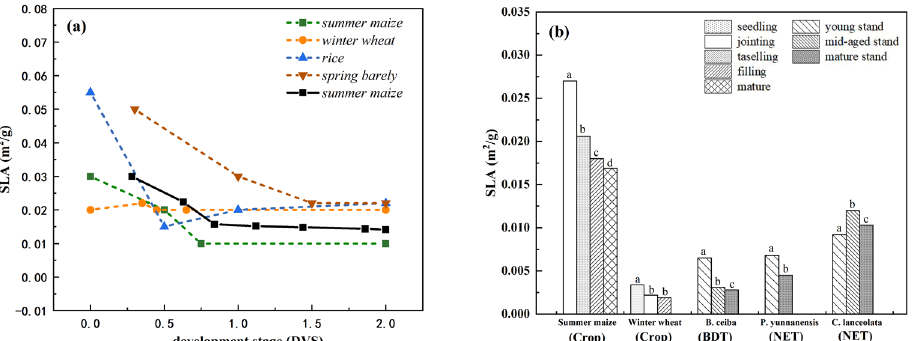
Figure 7. The changes in SLA values during key development stages (DVS) for different crops ( a ) and observed SLA values in various growth periods ( b ). For ( a ), the dotted lines are the default SLA values at different DVS in the WOFOST model and the solid line is the observed SLA values of summer maize at the Gucheng site in China. DVS values range from −0.1 at sowing to 0.0 at emergence, 1.0 at flowering, and 2.0 at physiological maturity. For ( b ), the different lowercase letters indicate significant differences at the 0.05 level. More details about the species can be found in Table S2 [53-57].